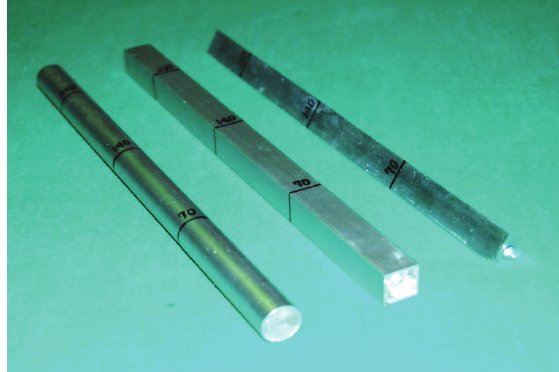
Fig. 2. Body section shape of the test cylinder (circular cylinder, square cylinder, and triangular cylinder)